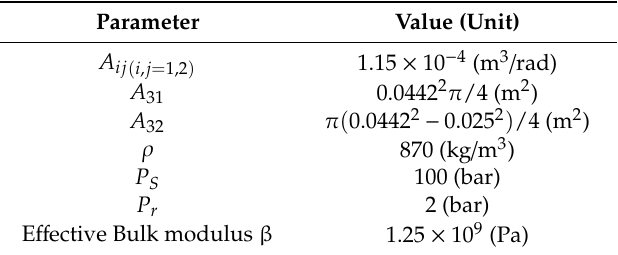
Table 4. The hydraulic parameters used for simulations.